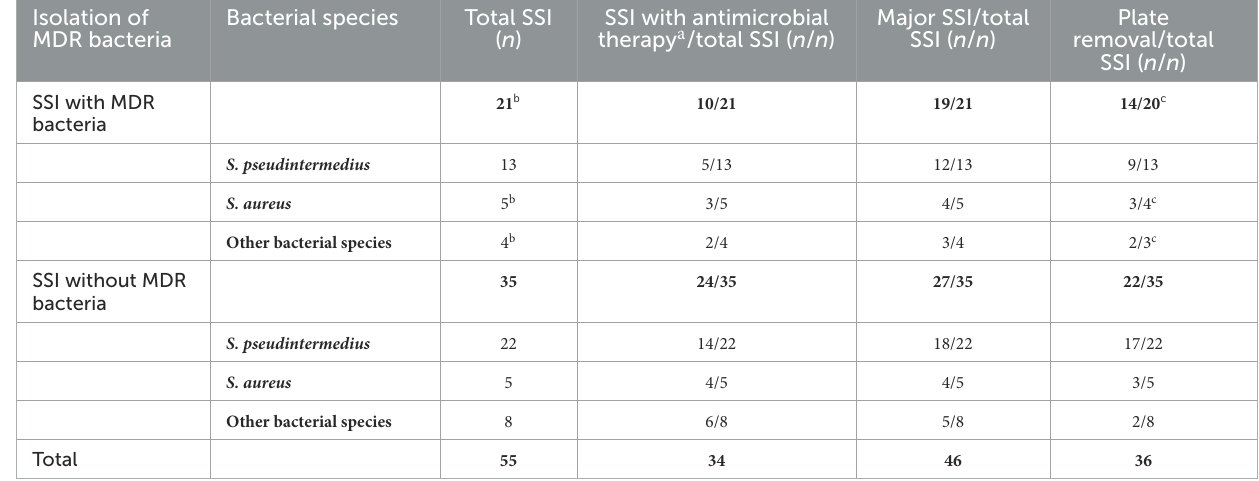
TABLE 4 Treatment and proportion of major SSI by isolated bacteria after 55 TPLO with positive bacterial culture results. Isolation of MDR bacteria